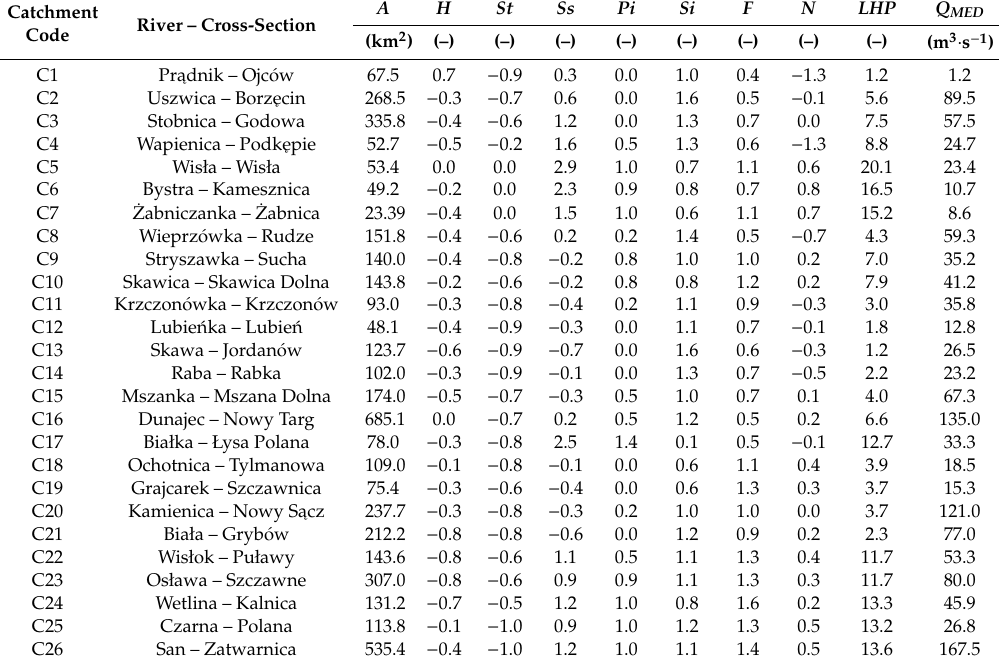
Figure 2. Location of analyzed catchments against the hypsometry in the Upper Vistula basin. Table 1. Values of attributes of catchment characteristics located in the Upper Vistula